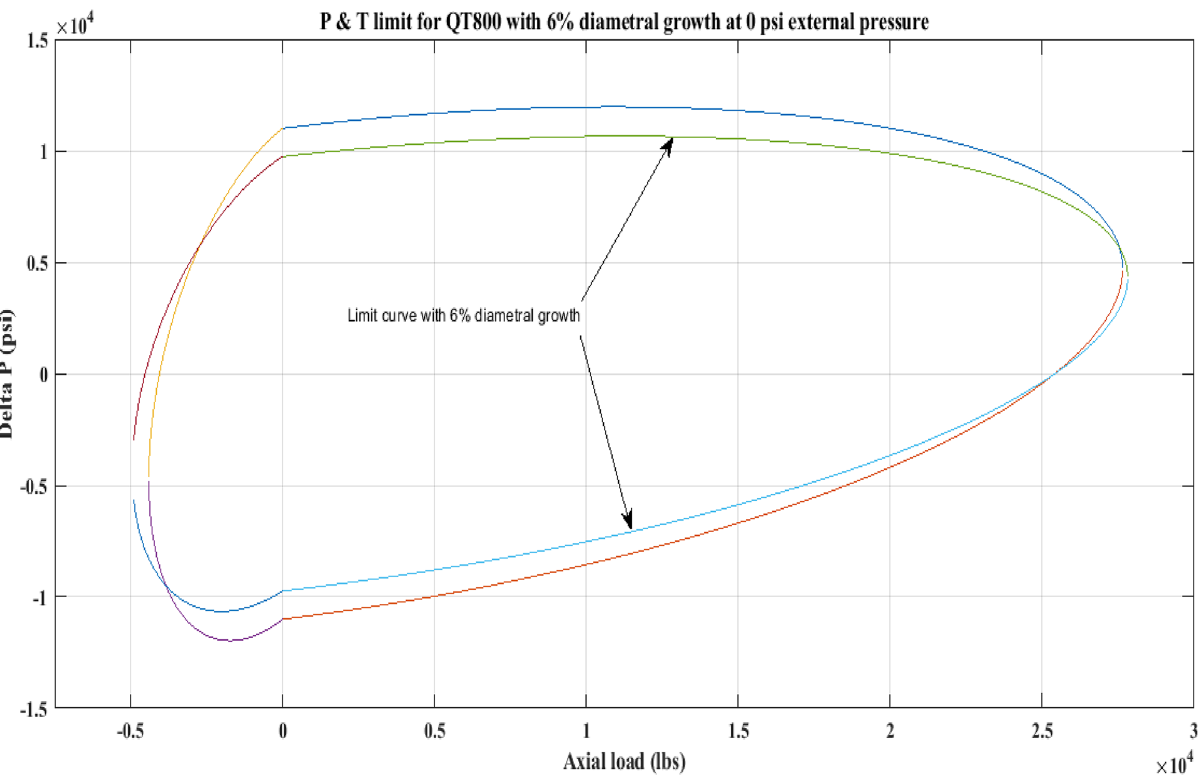
Figure 7. P and T limit with diameter growth for QT800 at 0 P o .